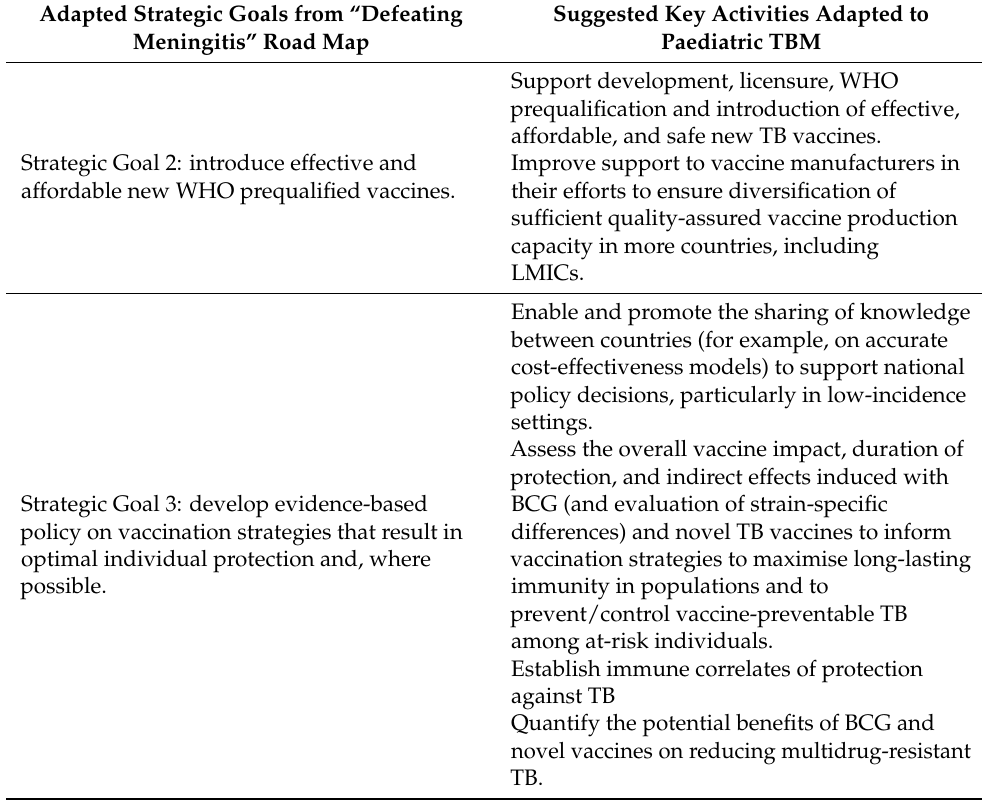
Suggested Key Activities Adapted